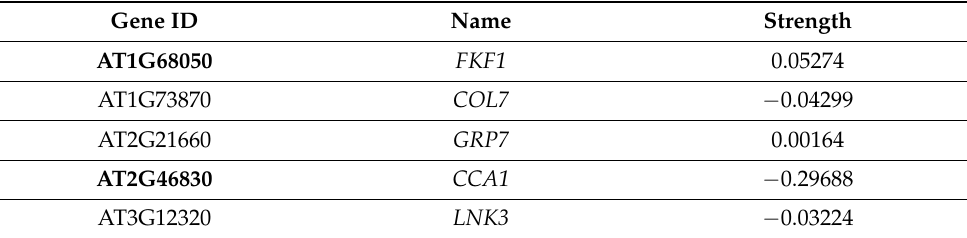
Table 5. Predicted interactions of LNK 1 gene using a fused graphical lasso.